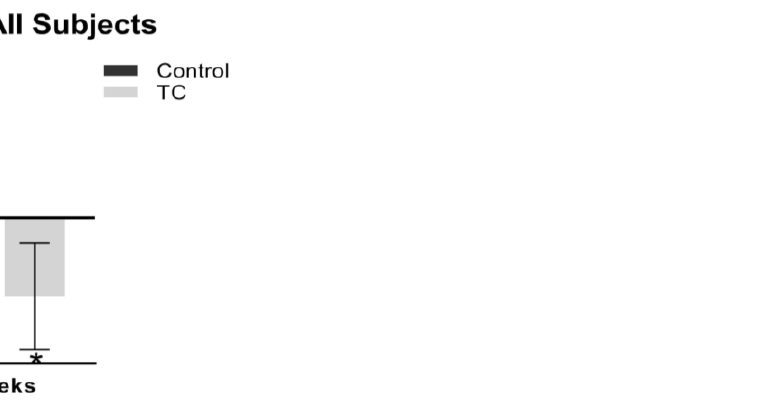
Figure 4. Cheek erythema after 8 weeks, compared to pretreatment baseline (all subjects). N = 38, * p < 0.05.